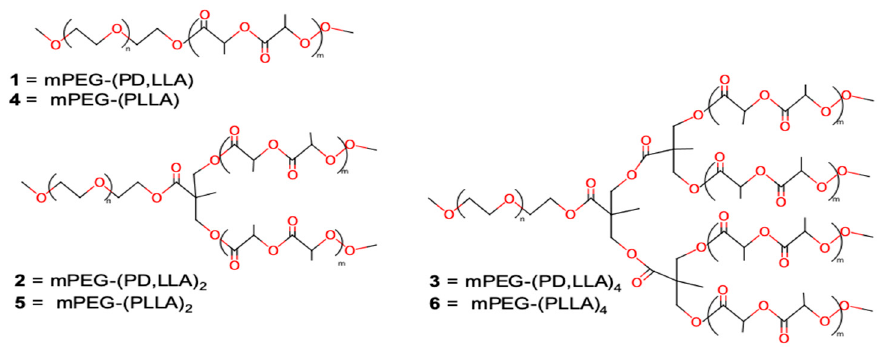
Figure 1. Copolymer structures. The numbers refer to the samples described in the relative entry of Table 1.